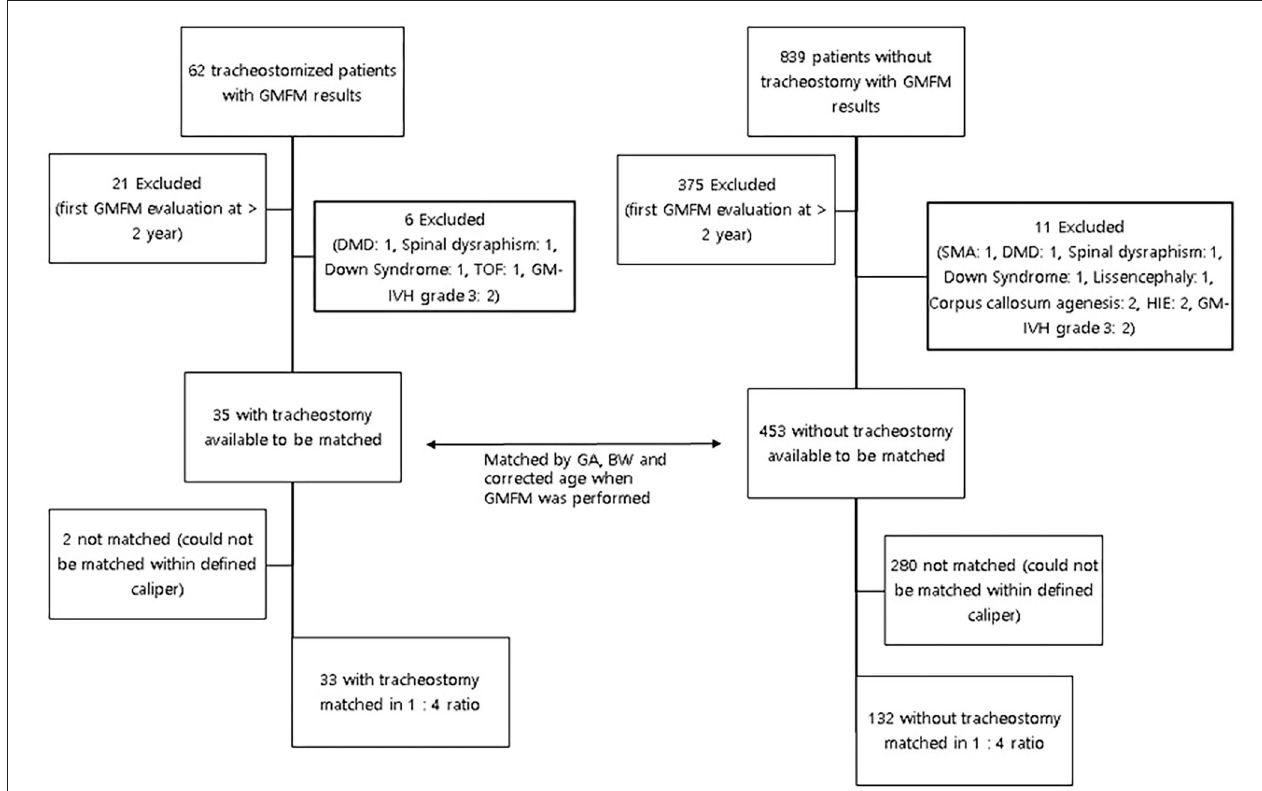
FIGURE 1 | Process for matching in infants with and without tracheostomies. GMFM, Gross motor function measure; DMD, Duchenne muscular dystrophy; TOF, Tetralogy of Fallot; GM-IVH, Germinal matrix-inraventricular hemorrhage; HIE, Hypoxic ischemic encephalopathy; GA, gestational age; BW, Birthweight.